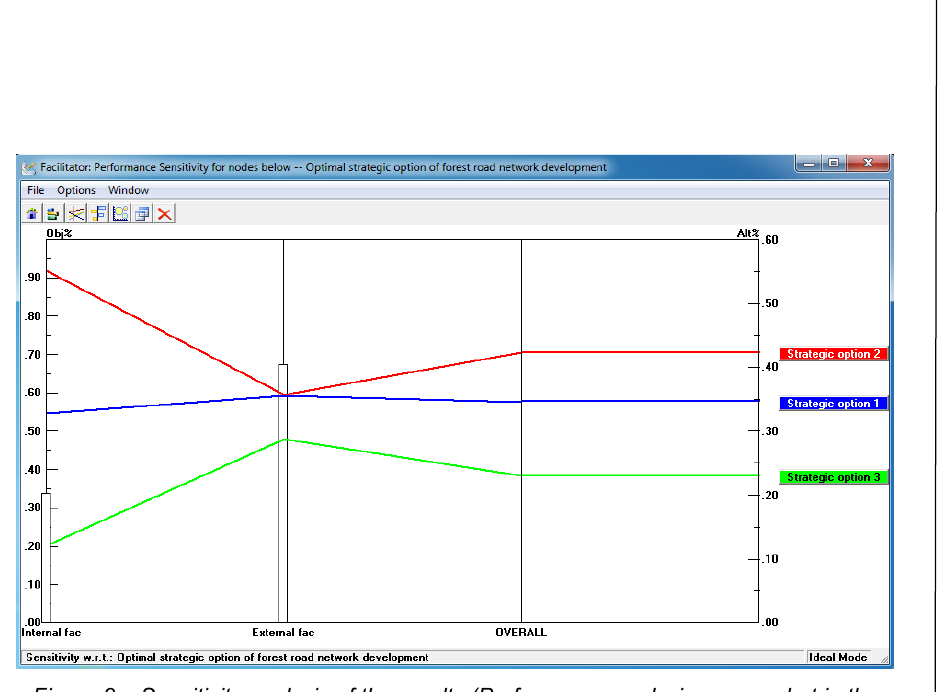
Figure 8 – Sensitivity analysis of the results (Performance analysis screen shot in the case of the dominance of the external